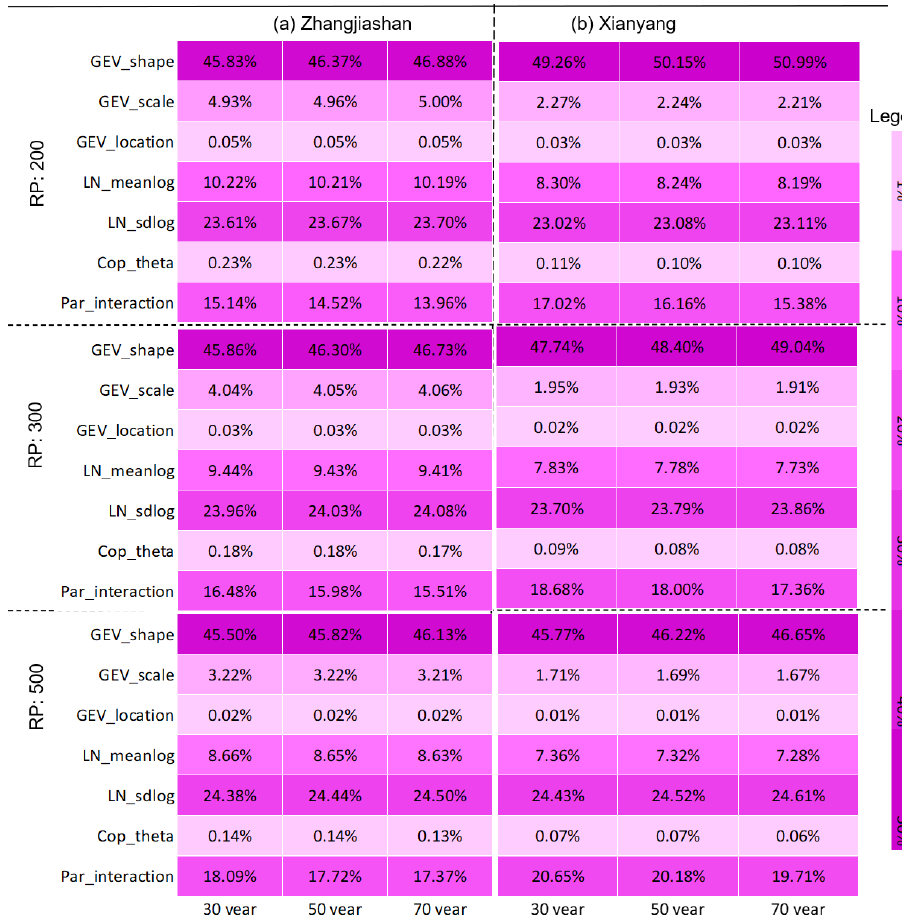
Table 7. Contributions of parameter uncertainties to predictive failure probabilities in AND under different design standards (i.e. return periods – RPs) and different service